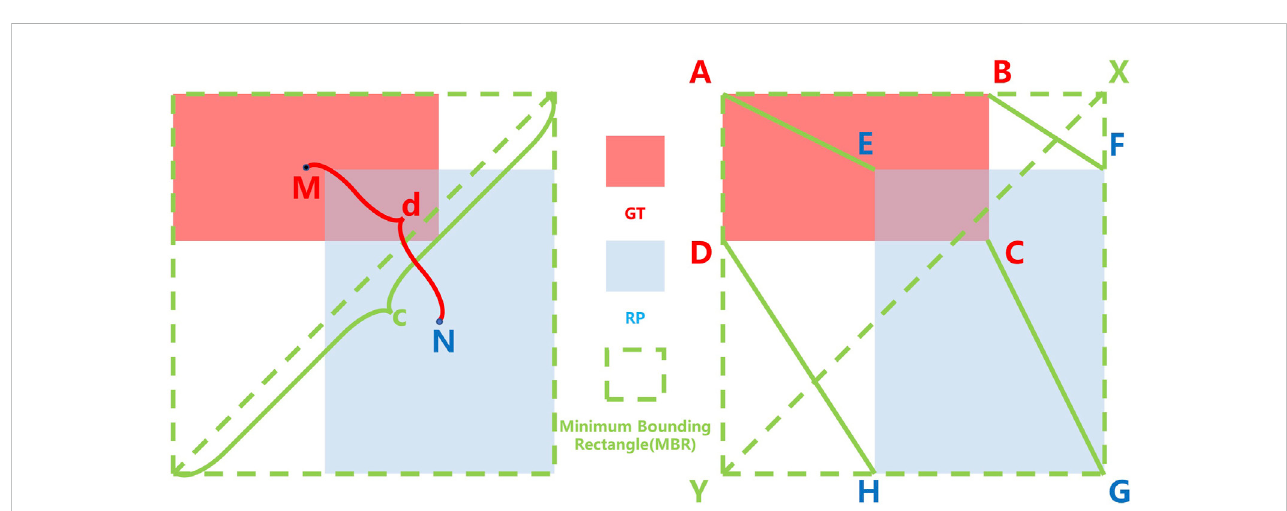
FIGURE 3 Calculation of IoU-based loss and Vertex Distance IoU (VDIoU) loss, where the red, blue, and green dotted boxes represent the Ground Truth (GT), RegionProposal(RP),andMinimumBoundingRectangle(MBR),respectively;M,NisthecentralpointofGTandRP,respectively;cisthedistancebetweenGT and the RP center point and d is the diagonal length of the MBR; A, B, C, D and E, F, G, H are the vertices of GT and RP,